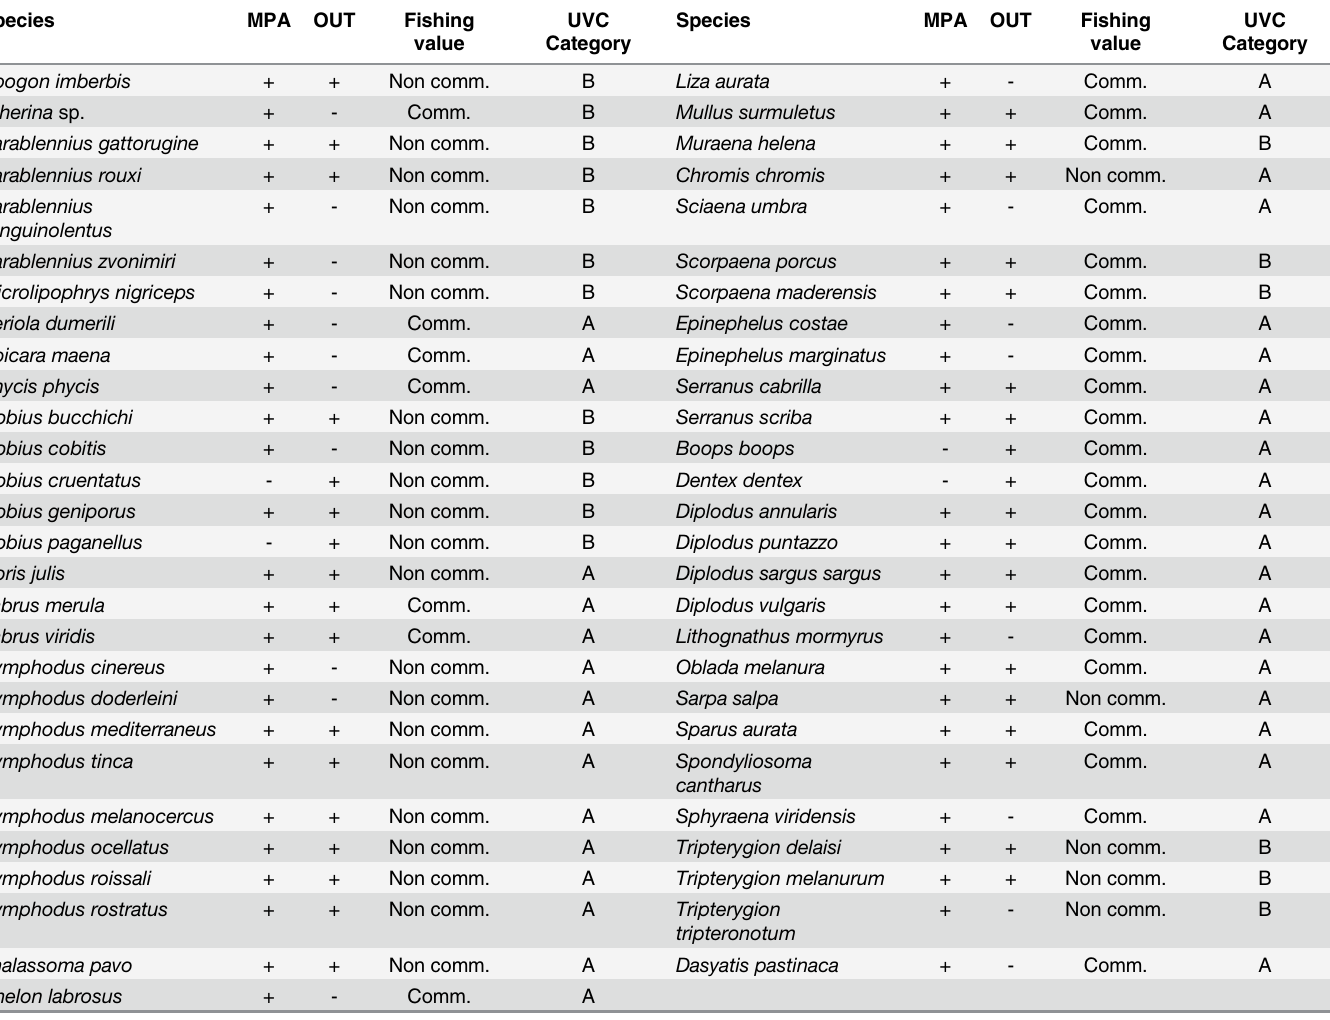
Table 2. Species composition of the fish assemblage inside and outside the Sinis